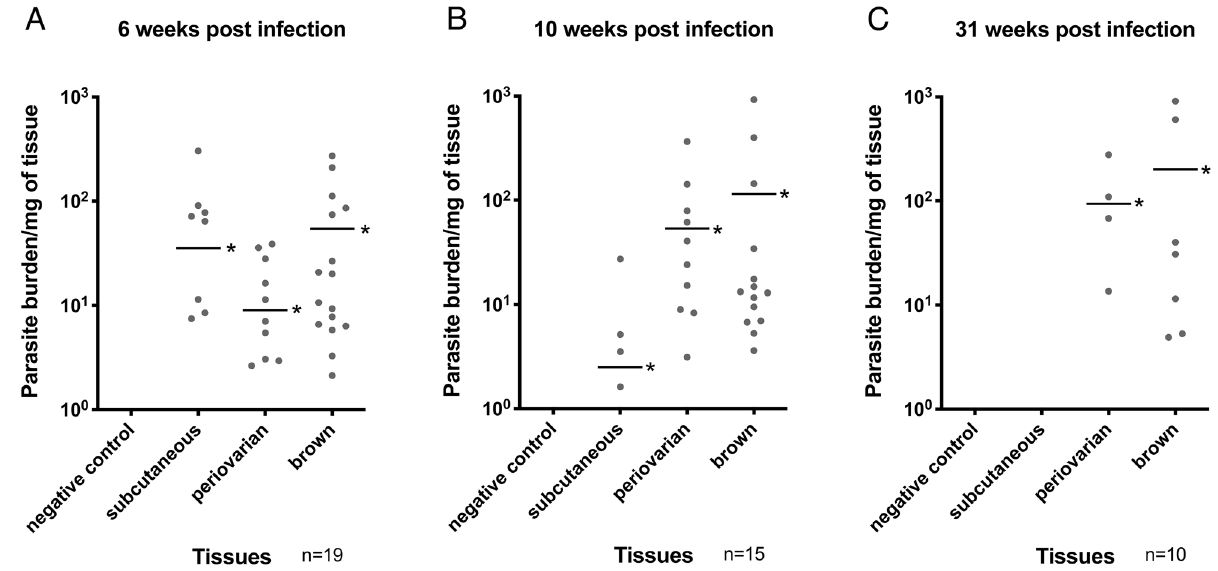
Figure 1. L. infantum parasites are present in adipose tissue from BALB/c mice. Subcutaneous, periovarian, and brown adipose tissue (25 mg) from mice inoculated with L. infantum were collected after different periods of time (6 ( A ), 10 ( B ) and 31 weeks post infection ( C )), DNA was extracted in a 100 µL volume and the presence of L. infantum DNA was determined by qPCR using a 2.5 µL DNA extract. Results represent parasite burden per milligram of tissue with SEM. *p < 0.05. qPCR negative samples are not shown on